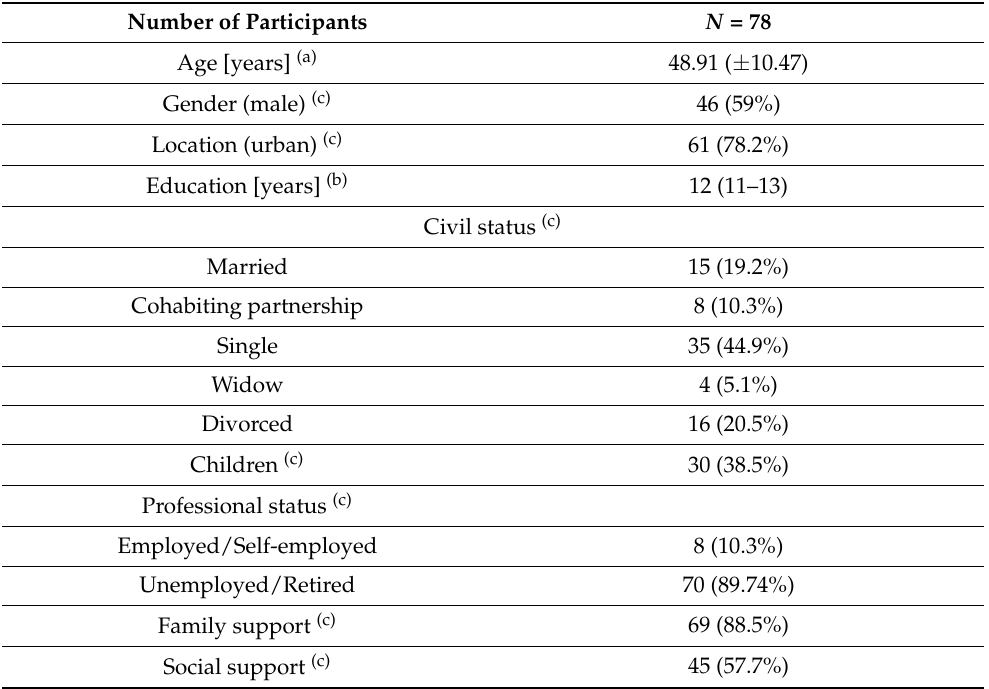
Table 1. Sociodemographic characteristics of the